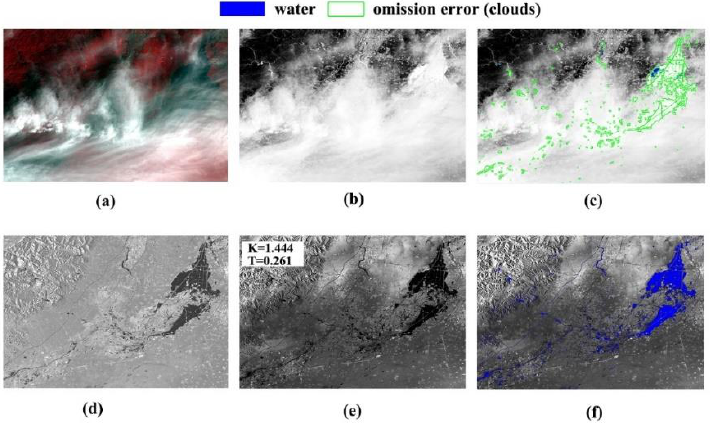
Figure 7. Results of the water extraction in Xunxian County, Henan Province, under the occlusion of clouds and fog: ( a ) Optical image. ( b ) NDWI. ( c ) Water extraction results based on the NDWI. ( d ) SAR image. ( e ) SOWI. ( f ) Water extraction results based on the SOWI.